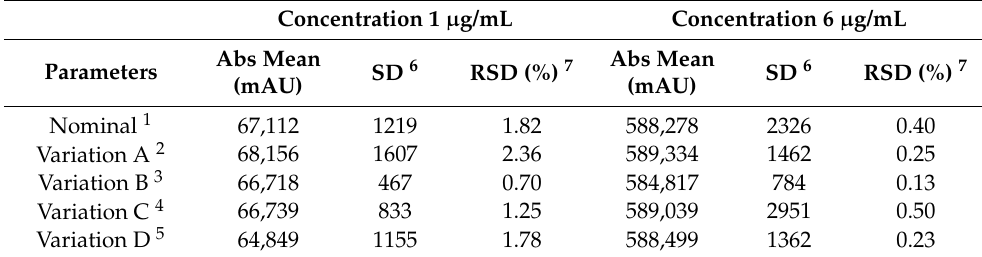
Table 6. Robustness evaluation of the new developed analytical